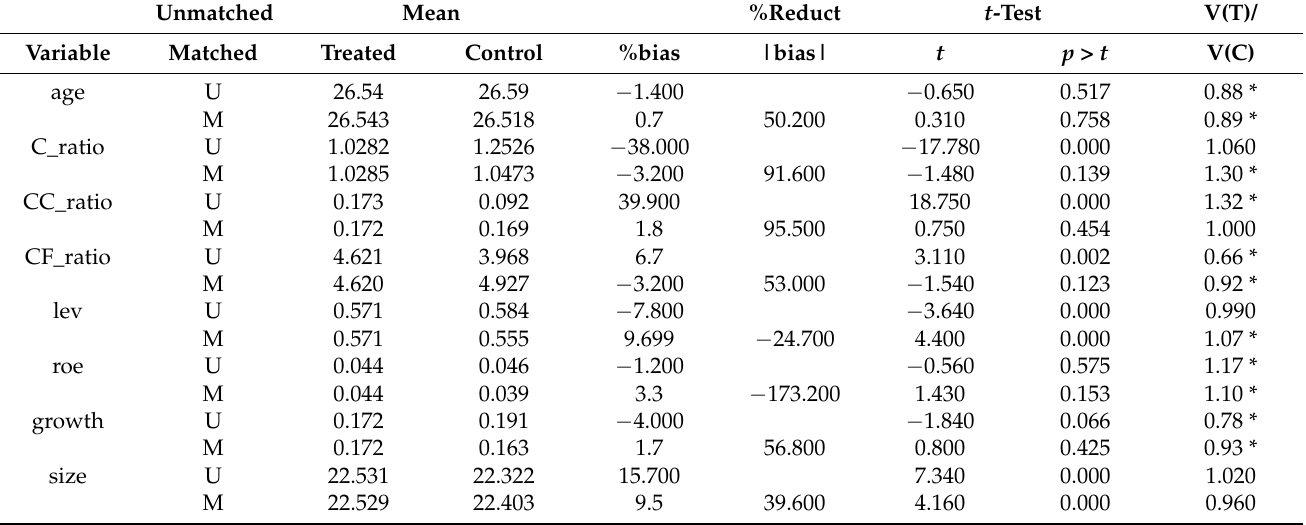
Figure 1. Comparison of standard deviation before and after matching. Table 3. Matching effect test.